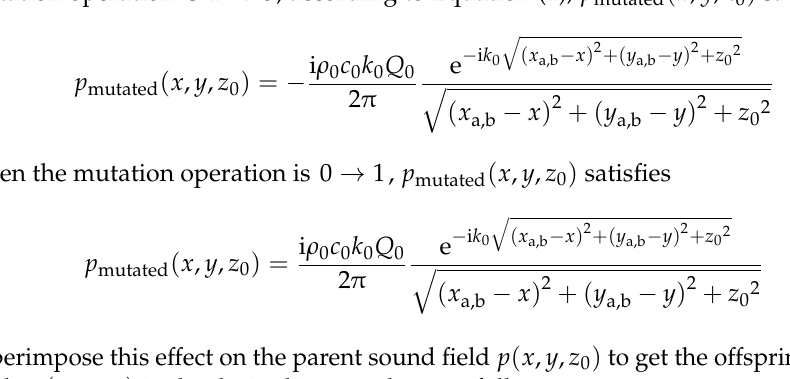
Calculate the effect of this mutation for the sound field in the desired image plane using the Rayleigh–Sommerfeld theory, represented by p mutated ( x , y , z 0 ) . When